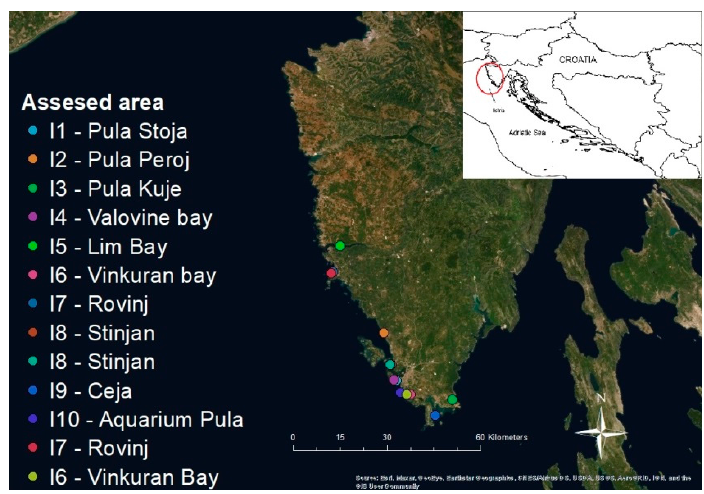
Figure 1. Sampling sites along the Istrian peninsula in the northern part of the Eastern Adriatic coast.